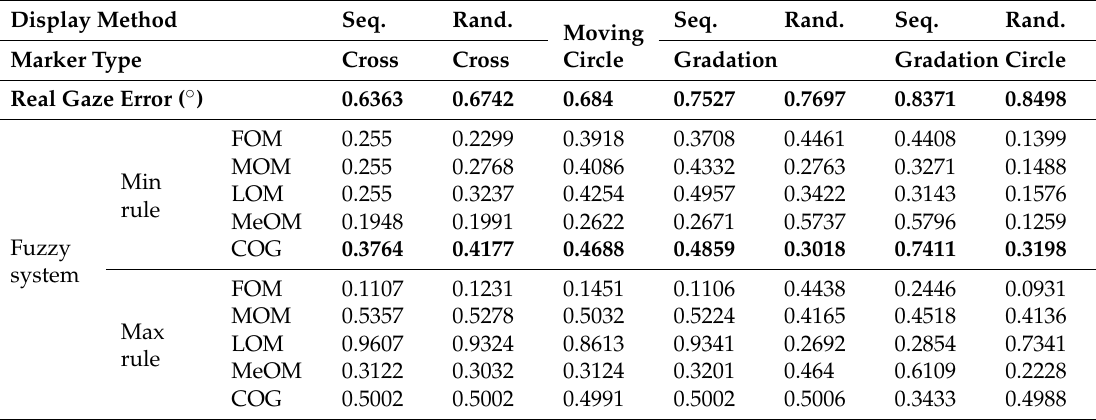
Figure 18. Results of a gradation marker type expressed sequentially: ( a ) an inaccurate calibration, ( b ) an error in the gaze tracking accuracy of 1.107 ˝ ; ( c ) an accurate calibration; and ( d ) an error in the gaze tracking accuracy of 0.487 ˝ . Table 3. Estimation results of gaze tracking accuracy according to the marker type and display method (Seq.: Sequential display, Rand.: Random